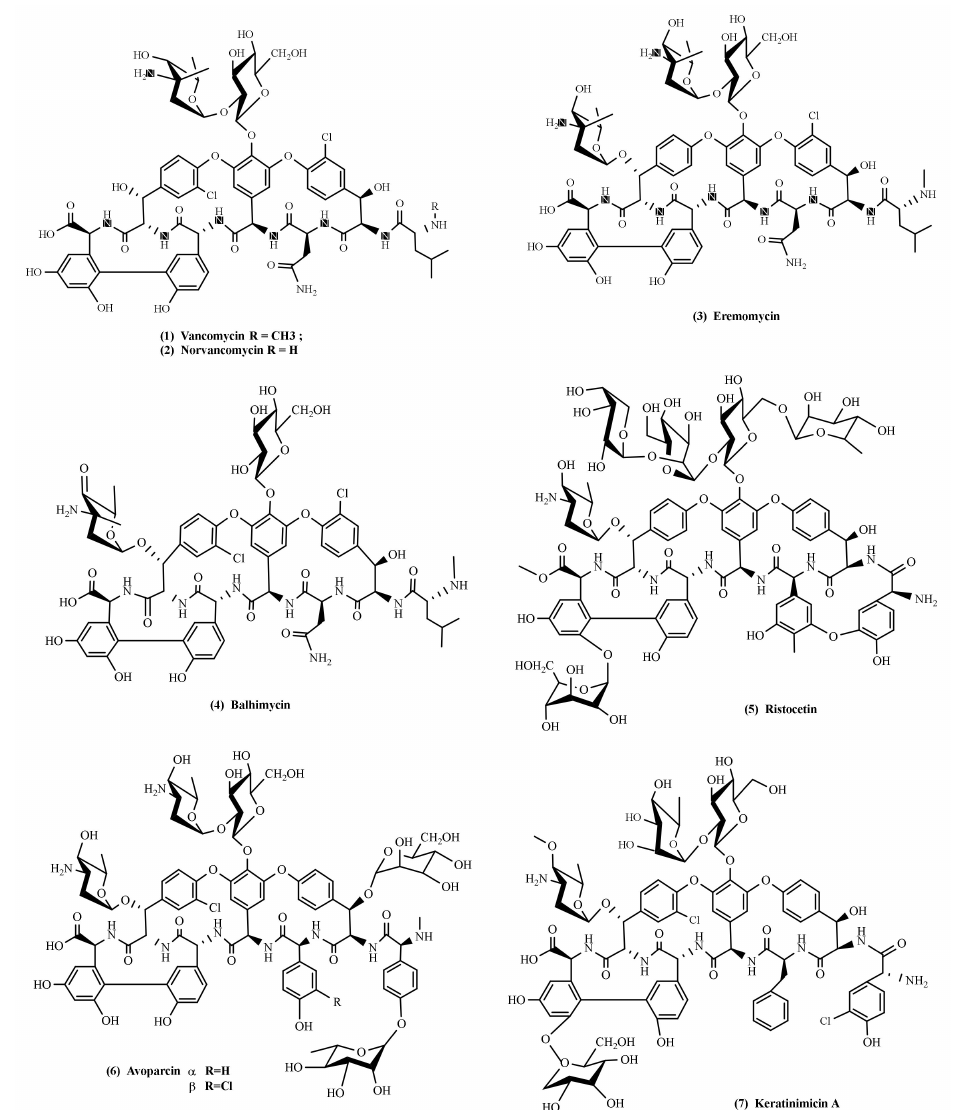
Figure 2. Glycopeptide antibiotics: ( 1 ) vancomycin, ( 2 ) norvancomycin, ( 3 ) eremomycin, ( 4 ) bal- himycin, ( 5 ) ristocetin, ( 6 ) avoparcin, and ( 7 ) keratinimicin